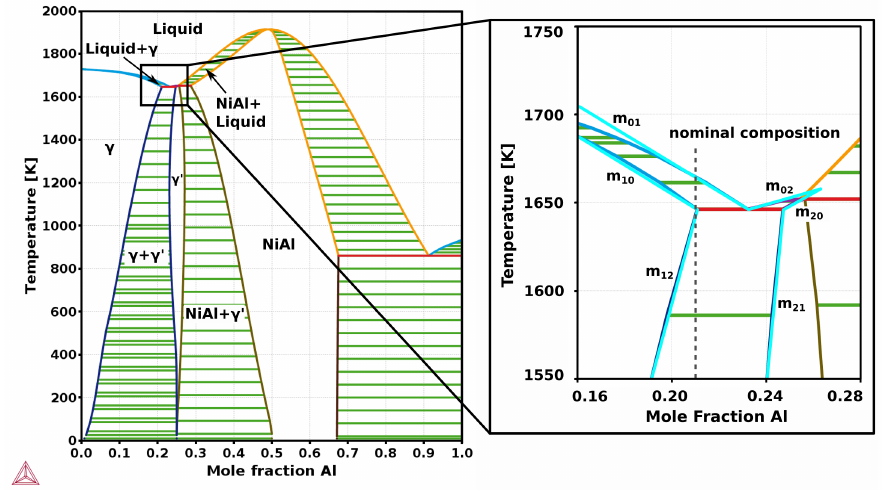
Figure 1. Left hand side: Phase diagram of the Ni–Al system (generated by ThermoCalc/TTNI7 database); right hand side: Linearized area of the phase diagram referenced in the simulations with the indication of the corresponding